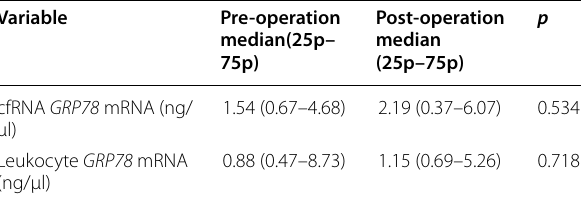
Table 2 Comparison results acording to patient and control groups pre and post operation